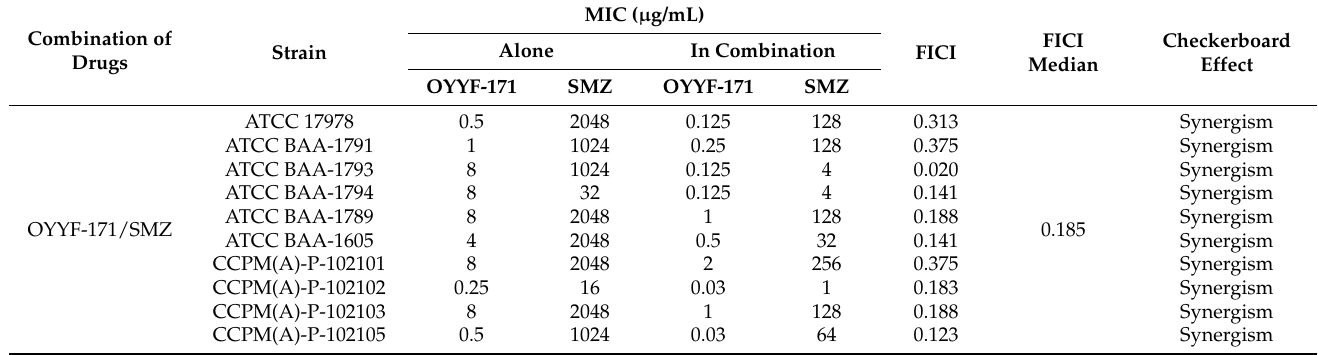
Table 4. Checkerboard results of the combination of OYYF-171 with SMZ, against A. baumannii . Combination of